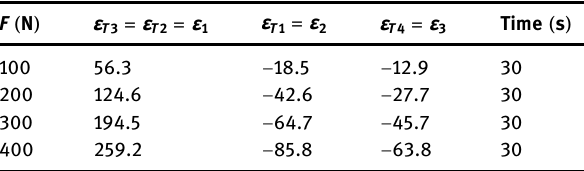
Table 4: Results of strain gauge measurement of composite sam -